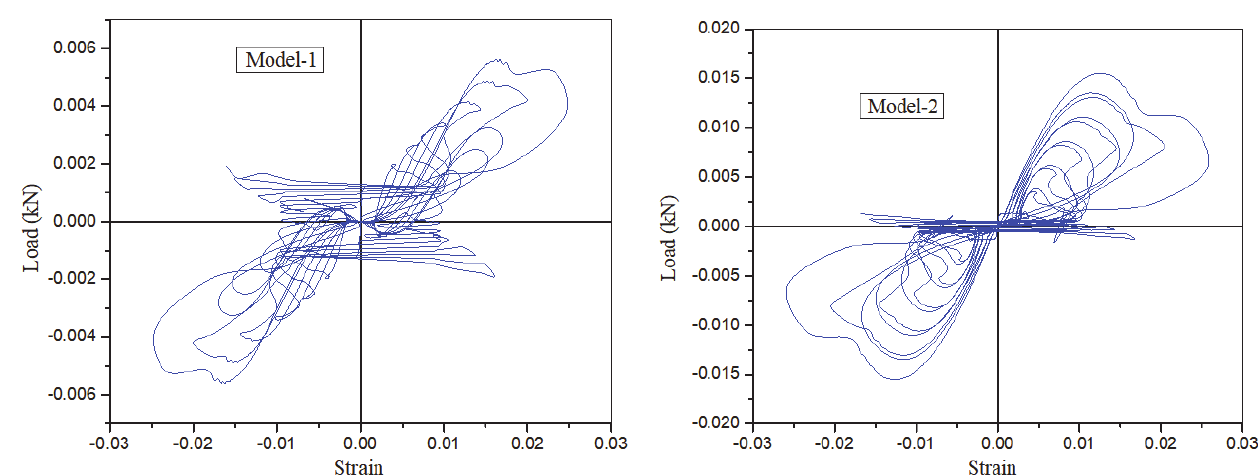
Figure 9: Load Vs strain on timber beam with 3.3 (m) length, model-1.